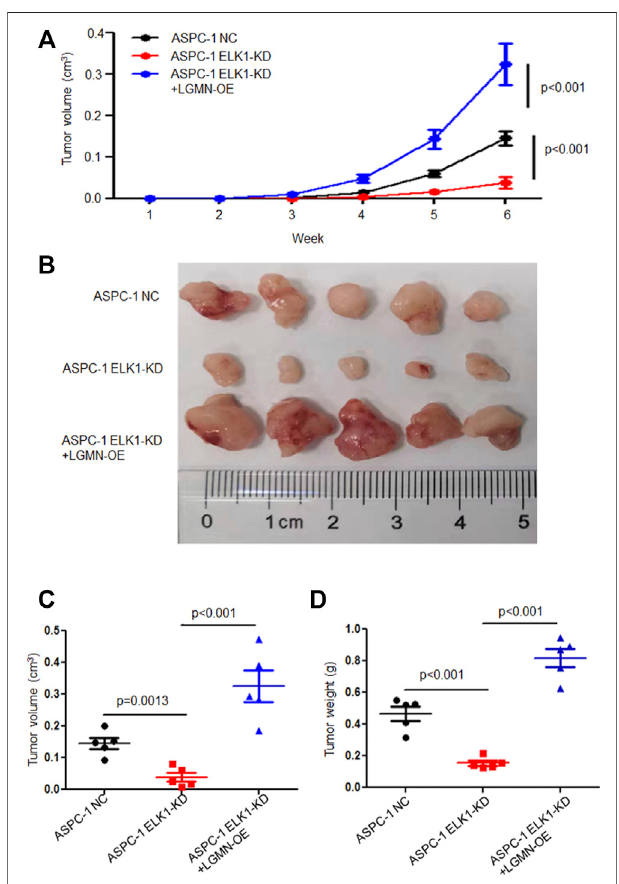
FIGURE6| ELK1promotedpancreaticcancercellsprogression via LGMN invivo . (A – C) TumorvolumeofASPC-1cellswithELK1knockeddownaswellas LGMNrescueweremonitored.* p < 0.001,** p < 0.001,betweenELK1-KDgroup and control group, ELK1-KD+LGMN-OE group and control group in ASPC-1cells (A) .* p (cid:1) 0.0013,** p < 0.001,betweenELK1-KDgroupandcontrol group,ELK1-KDgroupandELK1-KD+LGMN-OEgroupinASPC-1cells (C) . (D) Tumor weight of ASPC-1 cells with ELK1 knocked down as well as LGMN rescued were analyzed. * p < 0.001, ** p < 0.001, between ELK1-KD group and